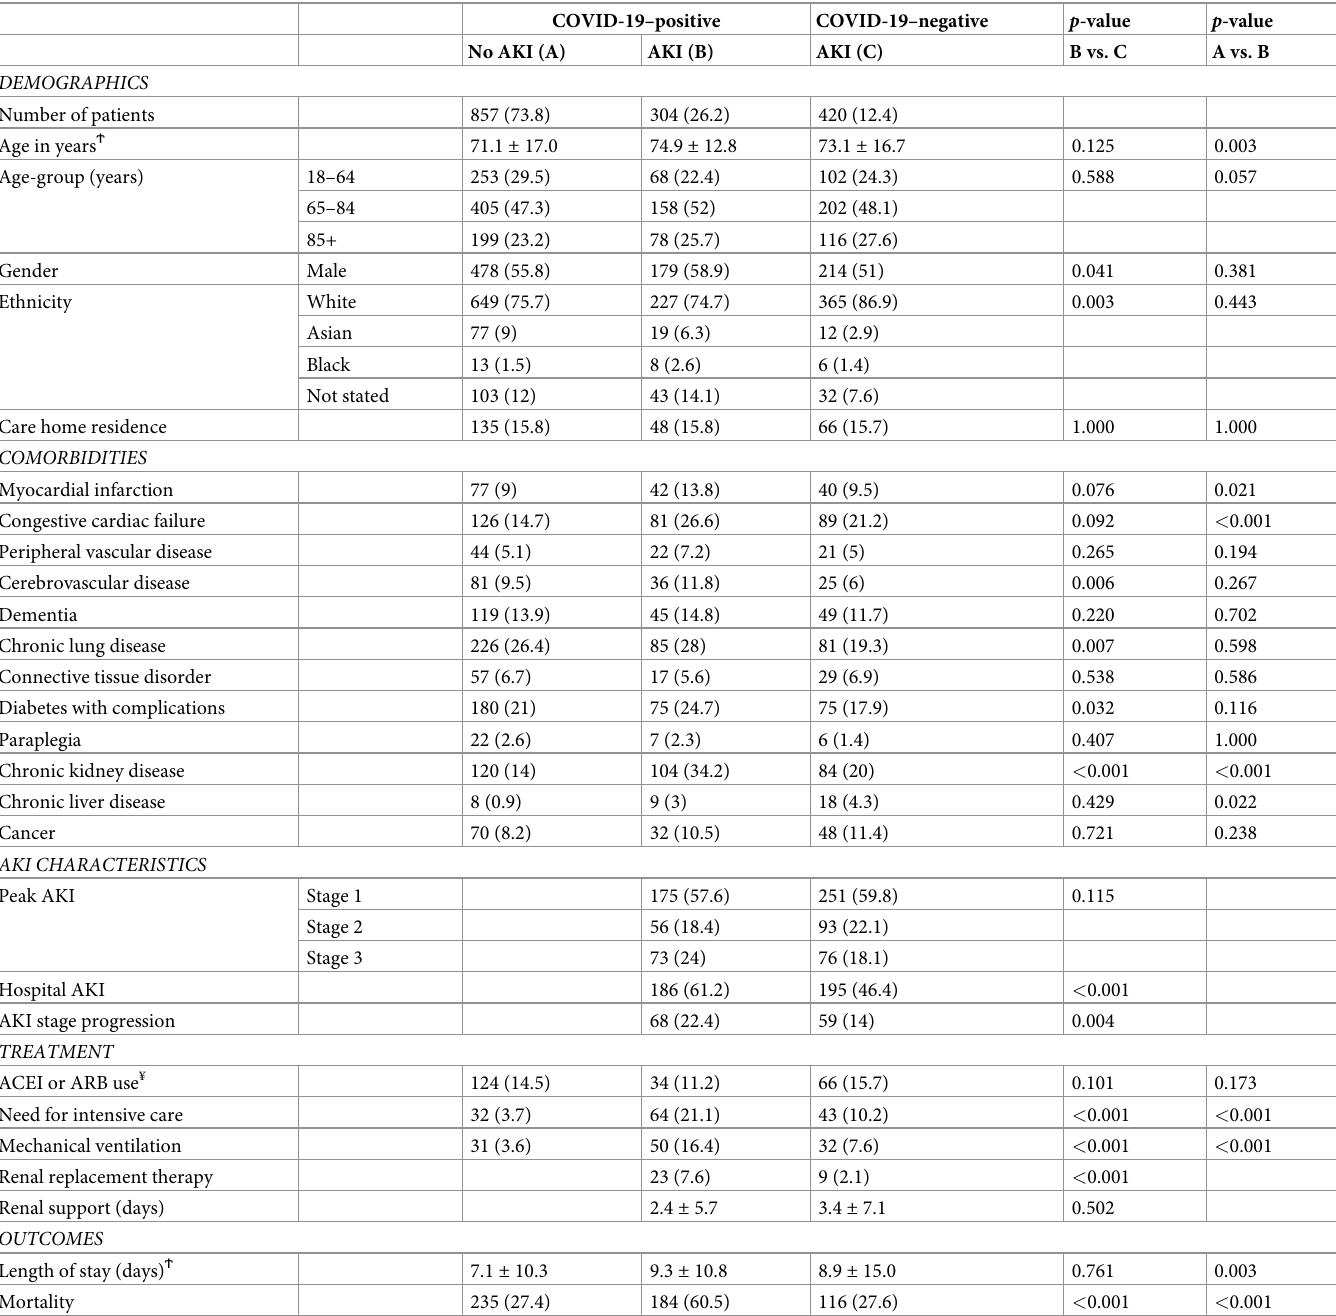
Table 1. Patient characteristics in groups with and without AKI according to COVID-19